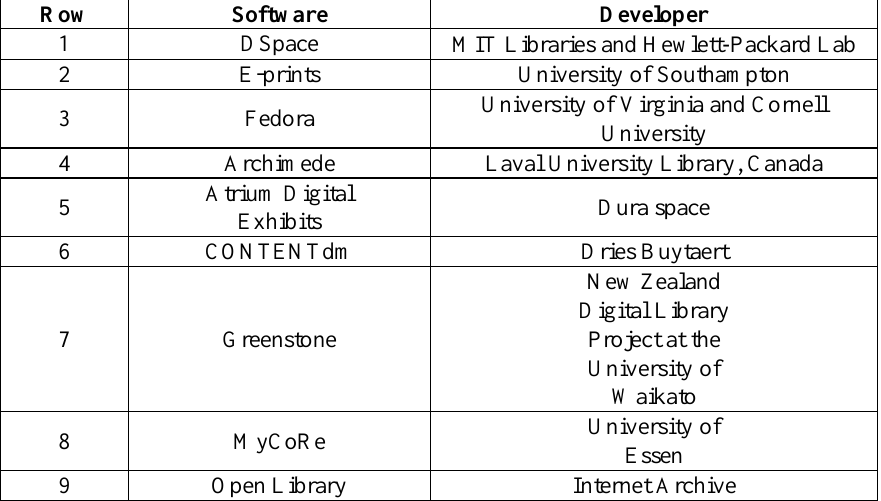
Table1.List of digital library